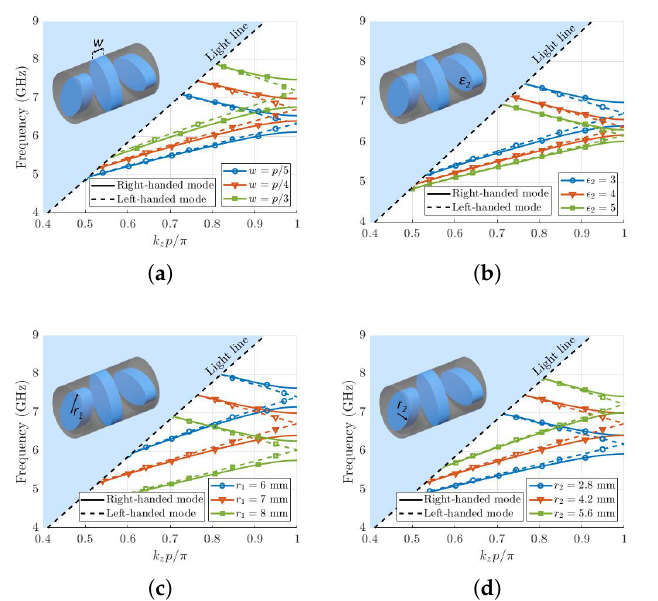
Figure 5. Dispersion diagram computation of a twist-symmetric dielectric rod as a function of ( a ) w , ( b ) (cid:101) 2 , ( c ) r 1 , and ( d ) r 2 . Unless otherwise specified, the parameters are p = 15.4mm, r 1 = 7mm, r 2 = 4.2mm, w = p /4, (cid:101) 1 = 10, and (cid:101) 2 =